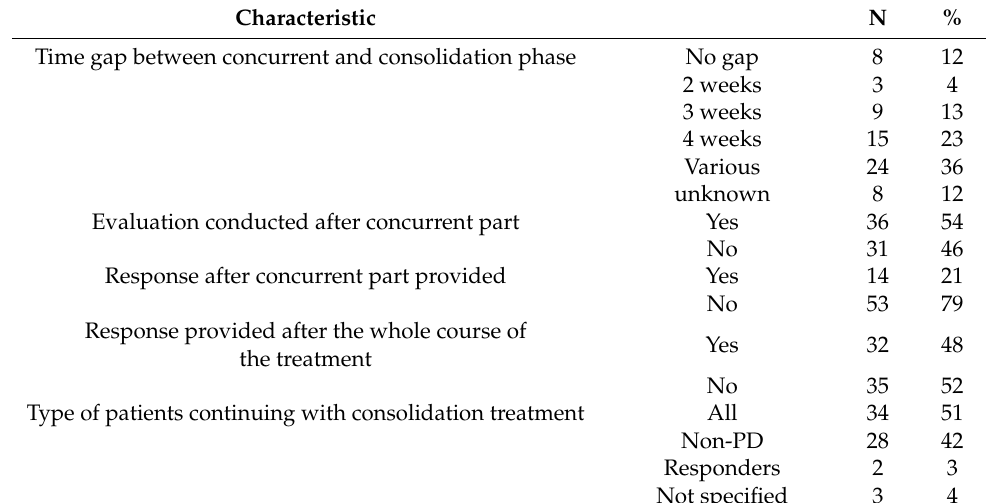
Table 2. Characteristics and results of